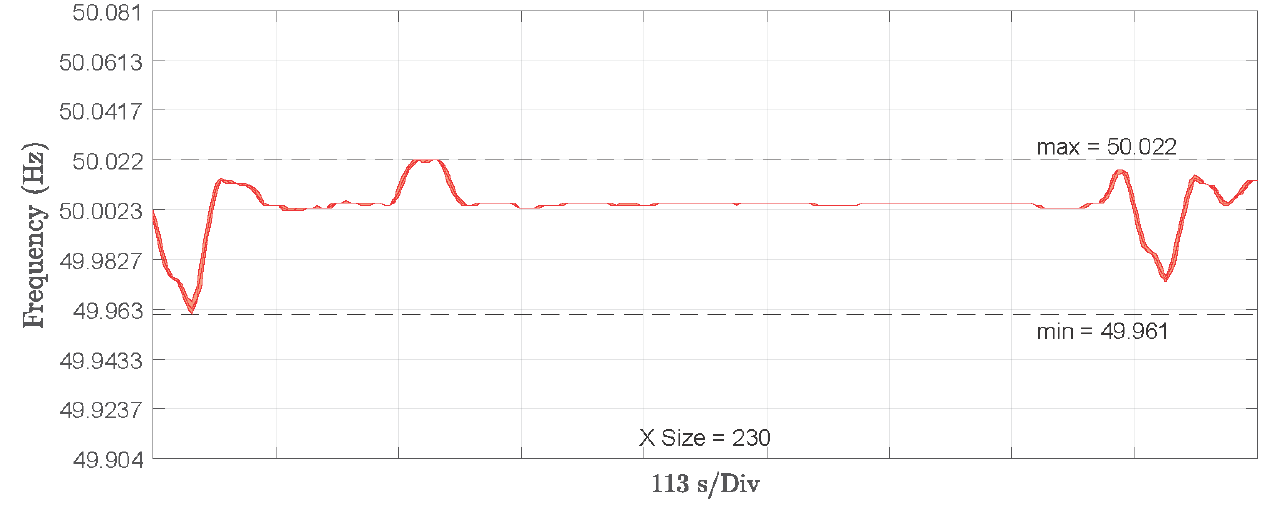
Figure 17. Frequency variation results versus changes in active power (winds gusts).